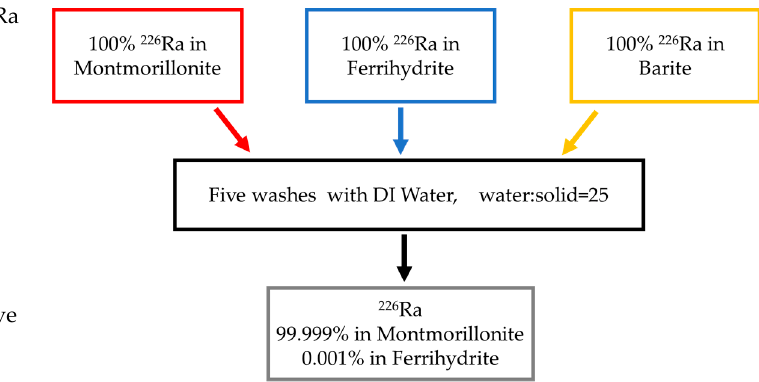
Figure 4. Illustration of the redistribution of the 226 Ra after five washes with deionized water. 226 Ra distribution in the mineral assemblage ( a ) before reaction, the 226 Ra was initially considered to be on montmorillonite or ferrihydrite or barite, respectively; ( b ) after reaction with five washes of deionized water (water:solid ratio of 25). The result is the same for the three initial scenarios.